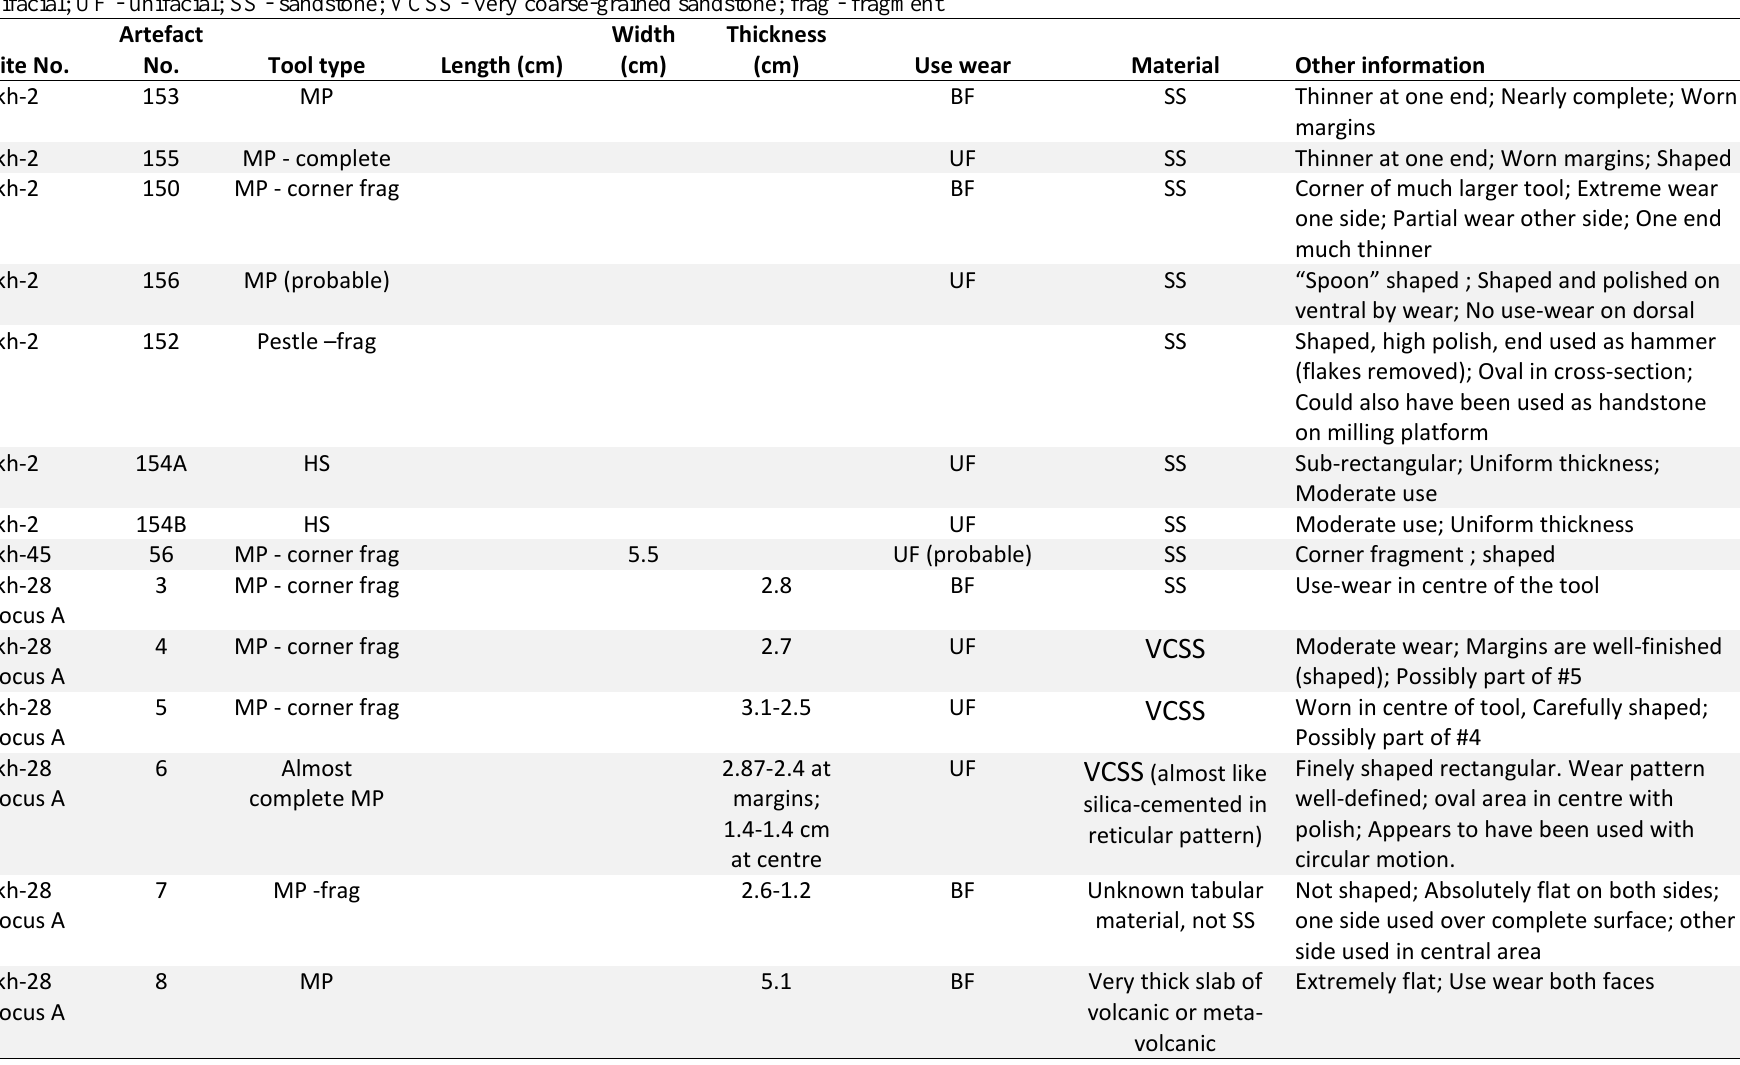
Table 1. Attributes of 22 milling tools from four sites in Ikh Nart Nature Reserve, Dornogovi Aimag, Mongolia. Abbreviations: MP - milling platform; HS - handstone; BF - bifacial; UF - unifacial; SS - sandstone; VCSS - very coarse-grained sandstone; frag - fragment Site